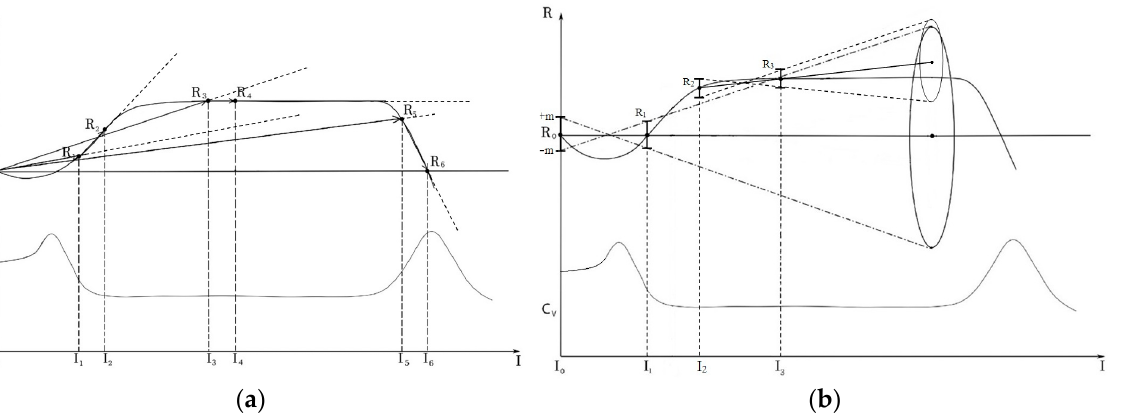
Figure 3. Biosystem response scheme ( a ) and difference in accuracy of system dynamics prediction ( b ) during paired photostimulation. Cv—coefficient of variation.